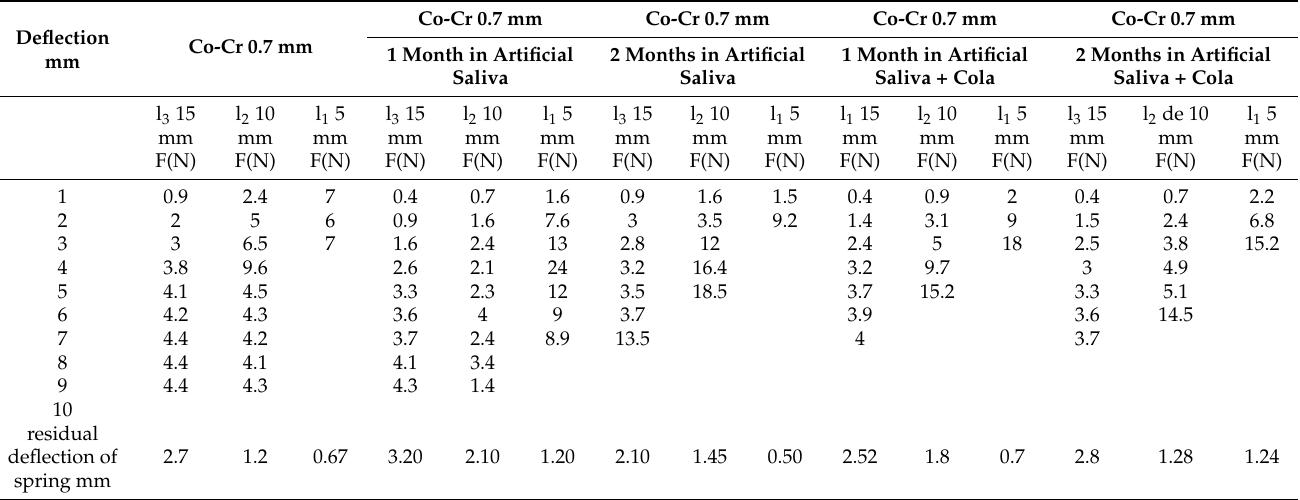
Table 2. Results for Co-Cr 0.7 mm arches.